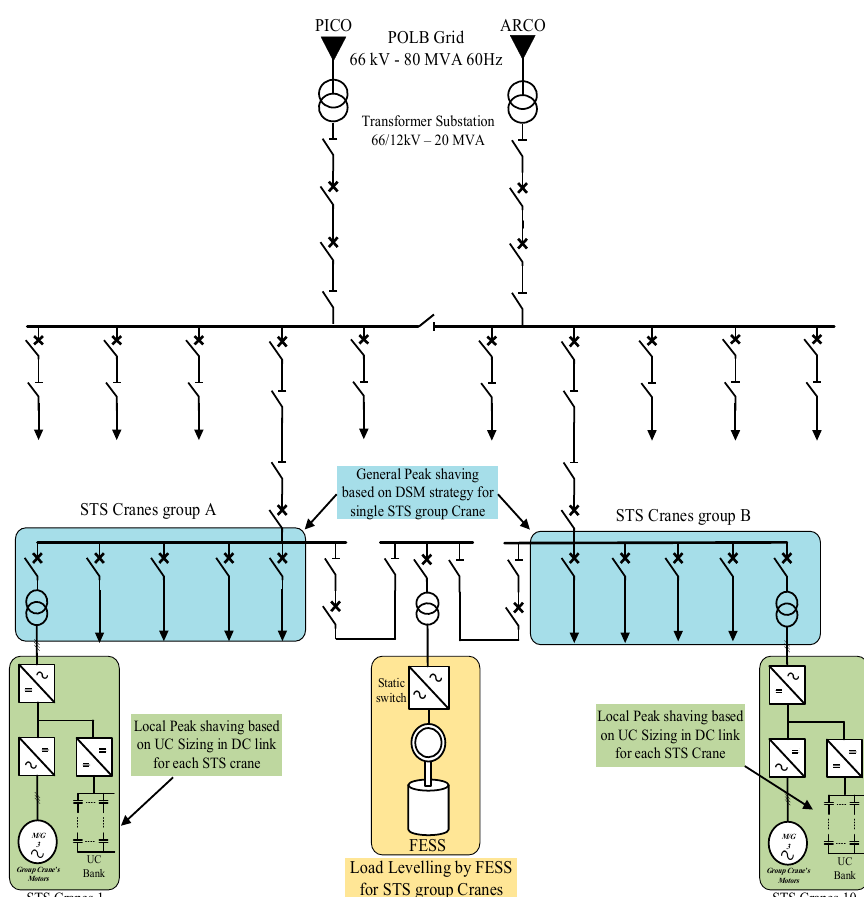
Figure 14. Hierarchical control of for peak load shaving in STS crane group.